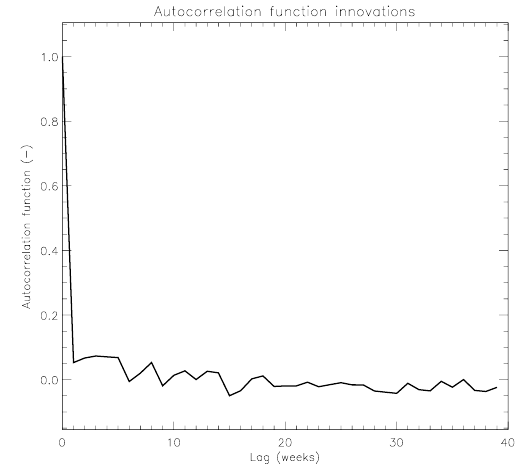
Fig. 5. Ensemble average of the autocorrelation function of the in- novations in step 8 of Fig. 1 for each ensemble member, for the case of sinusoidal observation and forecast biases and κ equal to